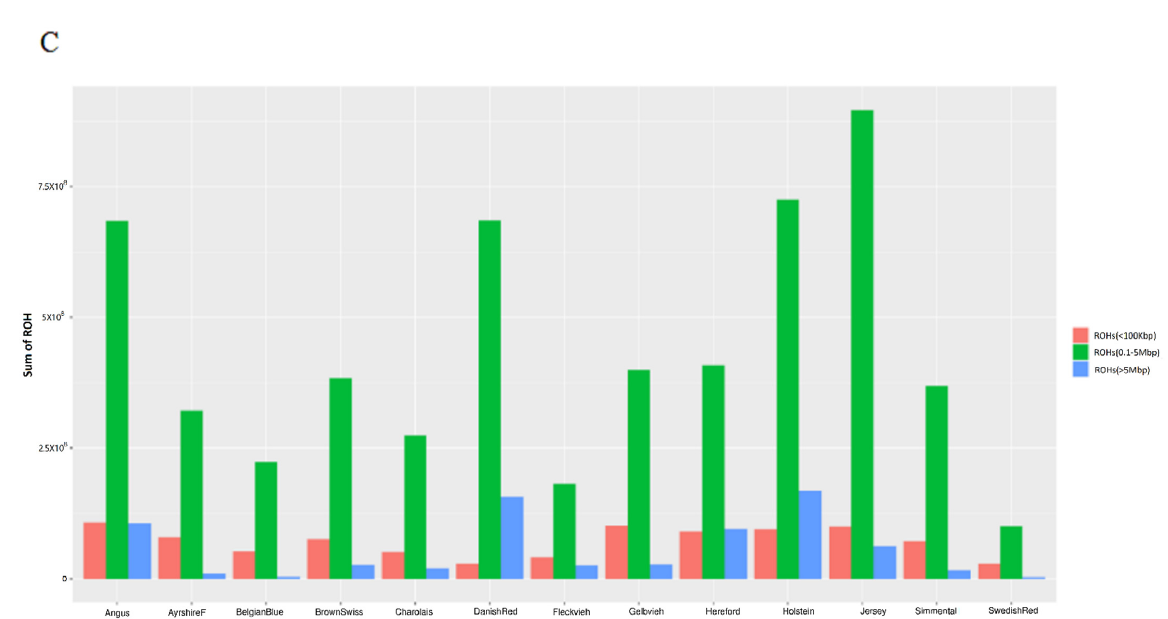
Figure 1. General statistics of ROH distribution in sequenced populations. ( A ) The proportion of the genome in ROH, the average ROH size and the number of ROH segments in the genome. ( B ) The number of ROH segments classified as short (S; red), medium (M; green) and long (L; blue) ROH. ( C ) The sum length of ROH segments classified as short (S), medium (M) and long (L) ROH. To reveal the demographic history of the sequenced populations, we plotted the numbers of ROH against the sum lengths of ROH (Figure 2). Out of 13 cattle breeds, An- gus, Jersey, Ayrshire Finnish Red and Simmental showed a medium number of ROH and medium total length in ROH, with most points locating in the middle of the plot (Figure 2). Fleckvieh, Charolais, Brow Swiss and Swedish Red had most points in the lower left corner of the plot, indicating a small number of ROH with a small sum of total ROH length. Danish Red was an extreme case, with a small number of ROH and large total ROH length. For the Holstein population, no clear patterns were observed. Instead, the ROH distribution between Holstein individuals was characterized by large variation, with a few Holstein individuals from the Netherlands showing extreme levels of inbreeding.